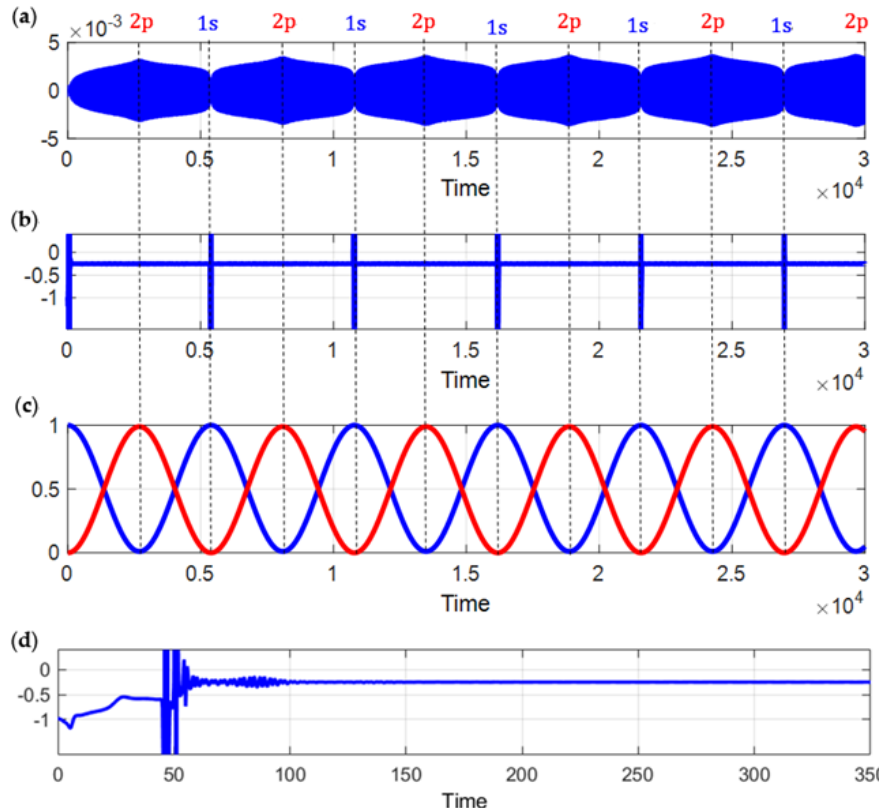
Figure 8. The time responses in the 1s–2p transition process: ( a ) The external electric potential energy V ext ( τ ) ; ( b ) The electron’s total energy E Total ( τ ) ; ( c ) The occupation probabilities of the two states, P 1 ( τ ) = | C 1 | 2 , and P 2 ( τ ) = | C 2 | 2 , which are represented by the blue line and red line; ( d ) Zoom in of the electron’s total energy (b). The total energy is − 1 when the electron is initially at the 1s state, and gradually becomes − 0.25 when the electron transits to the 2p